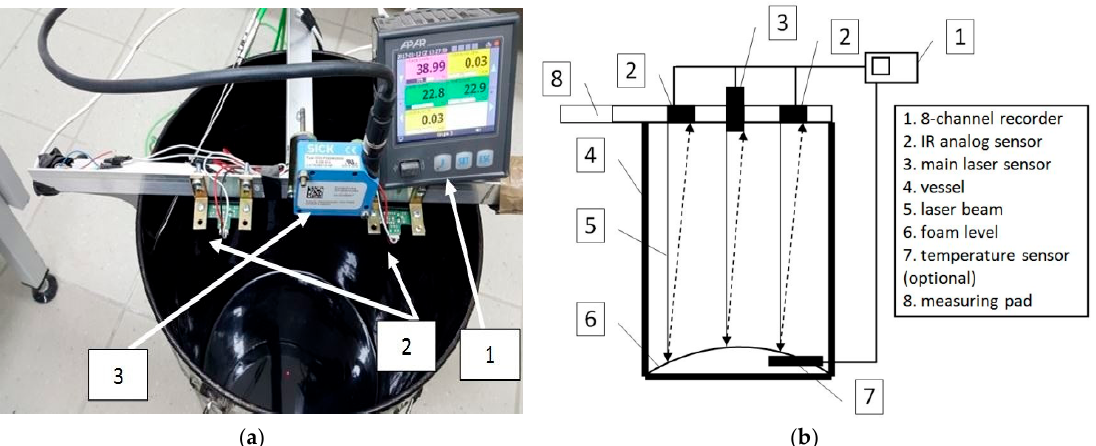
Figure 1. Original device for measuring bitumen foaming parameters (1, recorder; 2, IR analogue sensors; 3, laser sensor): ( a ) perspective frontal view; and ( b ) schematic diagram.